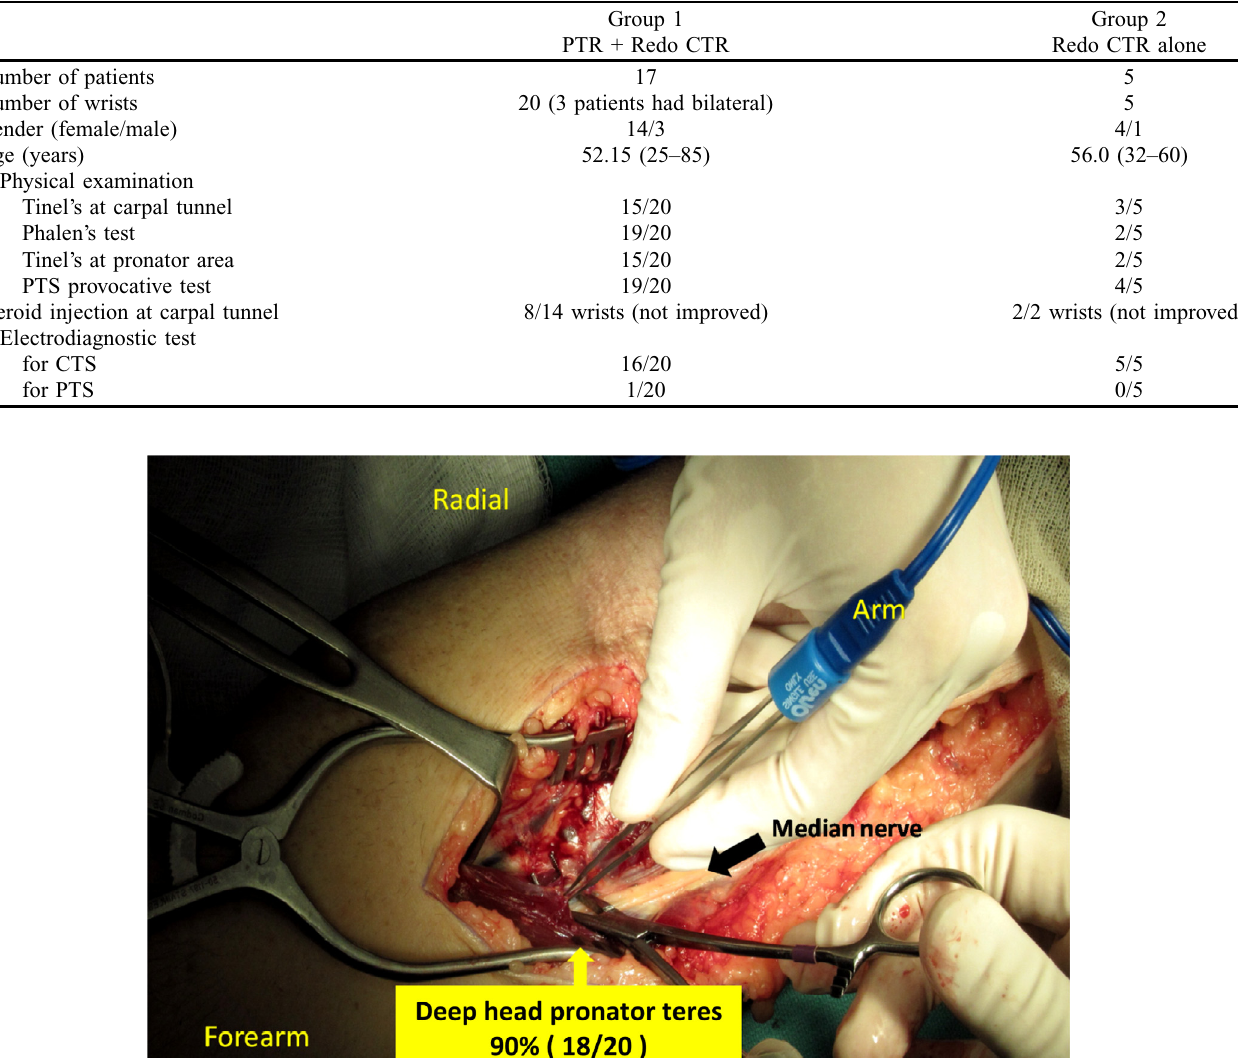
Table 1. Demographic data and preoperative evaluation.